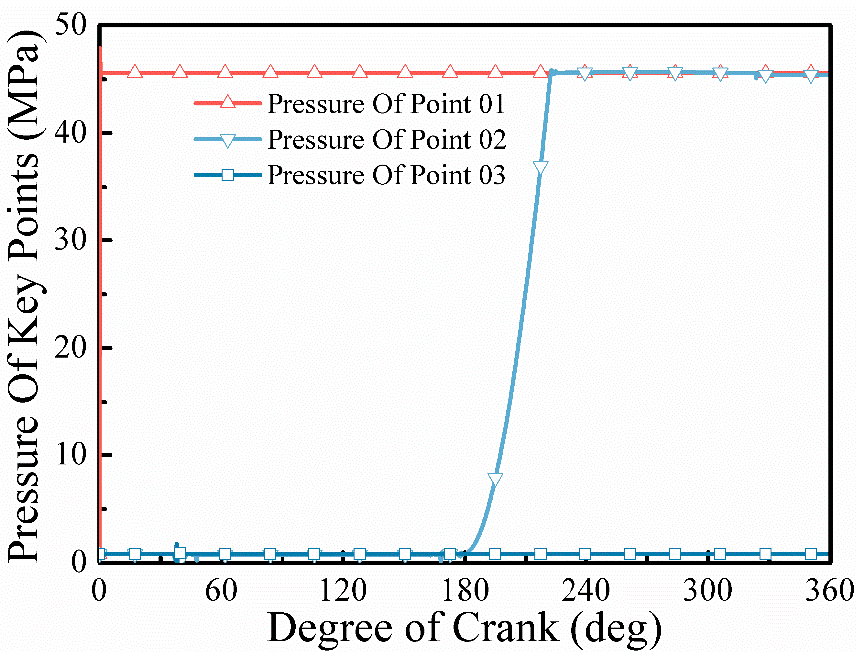
Figure 6. Pressure variation curve of flowfield at monitoring point.